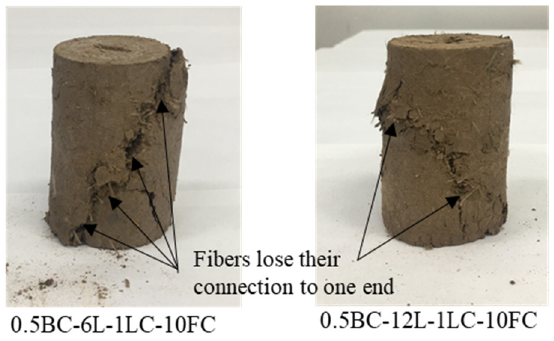
Figure 8. Failure forms of samples with 6 mm and 12 mm fiber length.